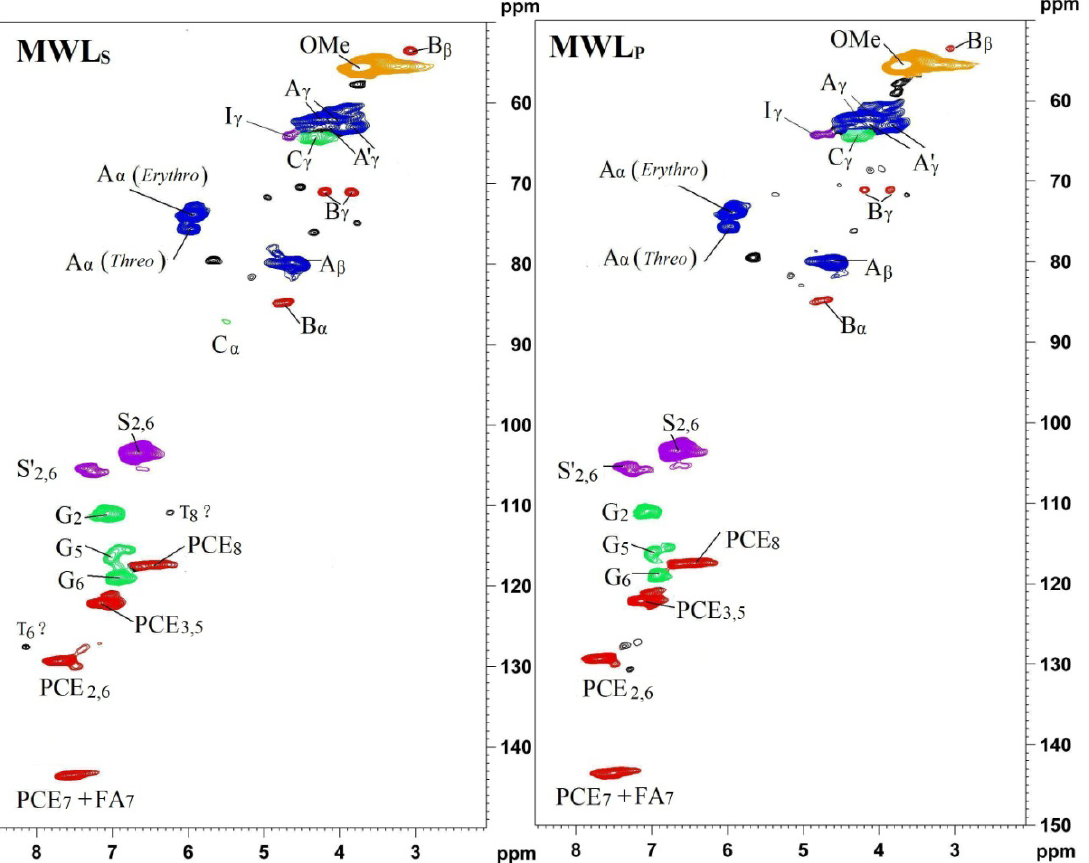
, S , represents MWL extracted from P